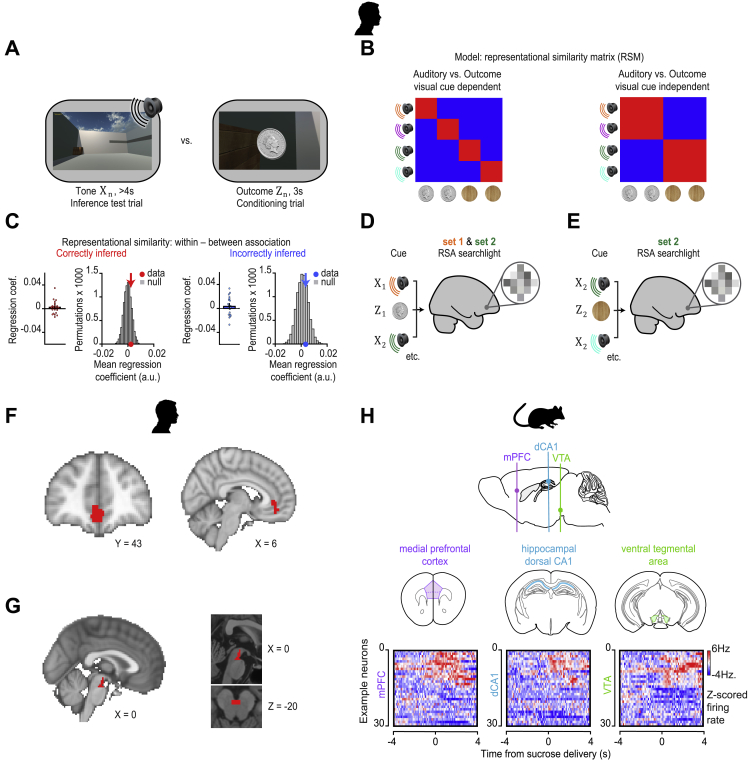
Representation of the Inferred Outcome in Humans and Triple-Site Recording of Neuronal Ensembles in dCA1, mPFC, and VTA in Mice, Related to Figure 6(A-G) In humans. (A) RSA was assessed between auditory cues Xn during the inference test, and outcome cues Zn during the conditioning trials. (B) Using multiple regression, representational similarity between the auditory cues Xn and outcome cues Zn was assessed using two models. The first model (left) mapped the relationship between the auditory cues Xn and the associated outcomes Zn, conditional on the intermediary visual cues Yn (Figures 6A and 6B). The second model (right) mapped relationships between the auditory cues Xn and the associated outcomes Zn, unconditional on the intermediary visual cues Yn. (C) RSA was applied to the BOLD signal extracted from the hippocampal ROI shown in Figure S3F. Using multiple regression to regress the data onto the two models described in B, during the inference test we assessed evidence for representation of outcome cues Zn in the hippocampus. During both correctly inferred and incorrectly inferred trials in the inference test, hippocampal activity did not significantly predict activity associated with the relevant outcome cues Zn, unconditional on intermediary visual cues Yn (correct and incorrect inference: Z21 = 0.91, p = 0.182 and Z21 = 0.84, p = 0.199). The group mean was further compared against a null distribution generated by permuting the identity labels assigned to the auditory cues Xn (correct and incorrect inference: p = 0.199 and p = 0.289). Results conditional on the intermediary visual cues Yn are shown in Figures 6A and 6B. (D-E) Searchlight RSA in humans was used to identify brain regions showing representational similarity between auditory cues Xn and outcomes Zn for cues in both set 1 and 2 (D) and for cues in set 2 only (E), where Z2 represents a neutral cue. (F-G) ROIs used to correct for multiple comparisons within the medial prefrontal cortex and VTA (Figures 6I and 6J). (F) An ROI in the medial prefrontal cortex, defined from functional map showing evidence for novel conjunctive representations in medial prefrontal cortex (Barron et al., 2013). (G) An ROI in the VTA, defined from a functional map identifying midbrain activation to reward-prediction error (Klein-Flügge et al., 2011). (H) In mice. Upper: Schematic showing the 3 simultaneously recorded brain regions: medial prefrontal cortex (mPFC), hippocampal dCA1 and ventral tegmental area (VTA) (n = 4 mice). Lower: Heatmap showing spiking activity of 3x30 example neurons recorded across the mPFC, dCA1 and VTA. For each heatmap, each row shows the Z-scored firing rate (Hz) of a given neuron within 100 ms bins, averaged across multiple trials in which sucrose is delivered to the outcome dispenser within the open field shown in Figure 1B. For each brain region the y axis is organized to first show those neurons that show an increase in their spiking activity in response to sucrose delivery. This triple-site recording shows that spiking activity in these three brain regions can be modulated in relation to experience of reward, and also illustrates how triple-site recordings may be used in the future to investigate findings reported in humans at a cellular level (Figure 6).